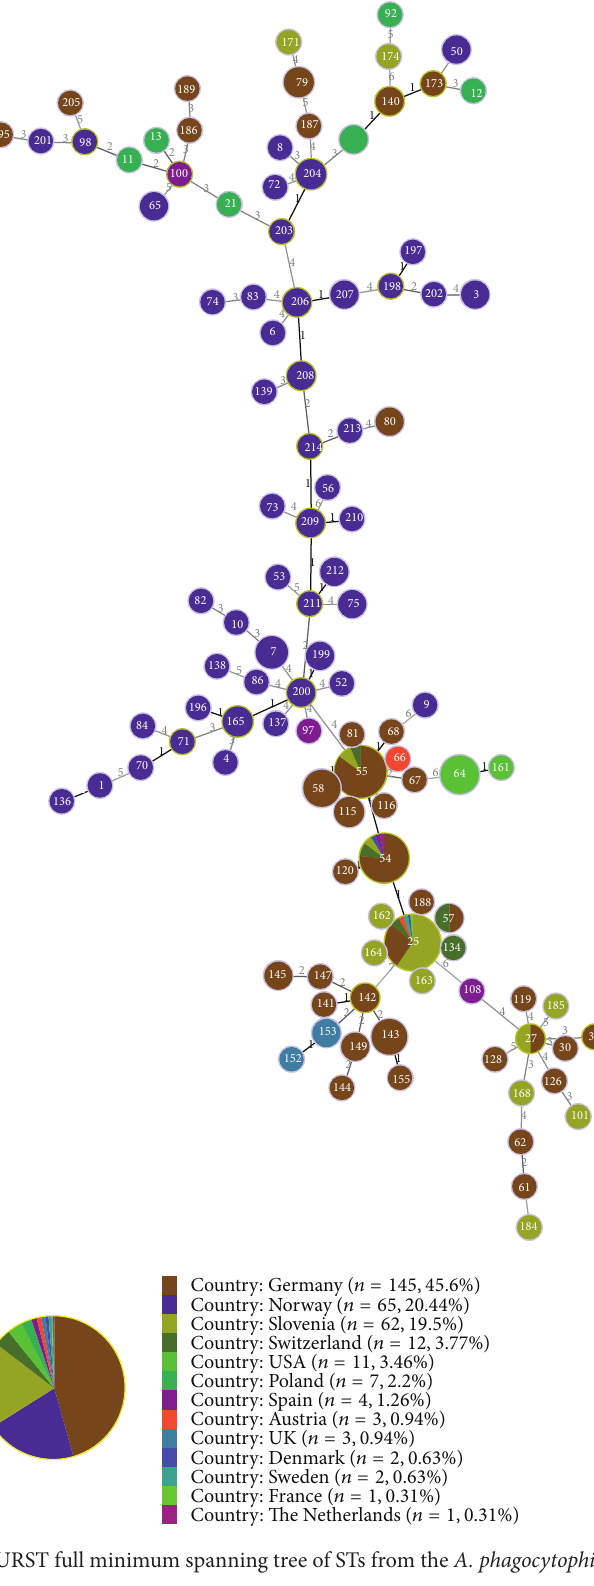
Country: The Netherlands ( n = 1,0.31% ) Figure 2: goeBURST full minimum spanning tree of STs from the A. phagocytophilum MLST